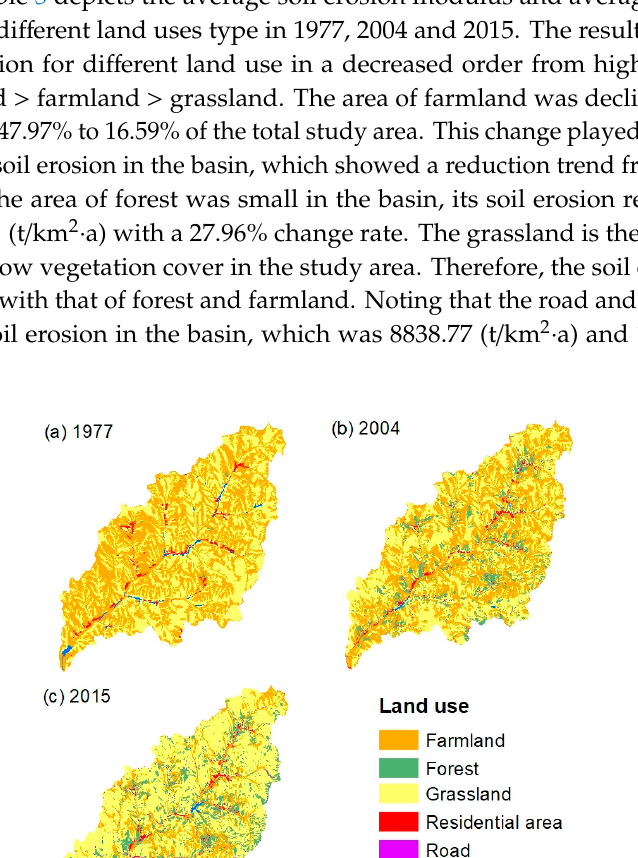
Figure 4. Spatial distribution of land uses during 1997–2015 in the study area